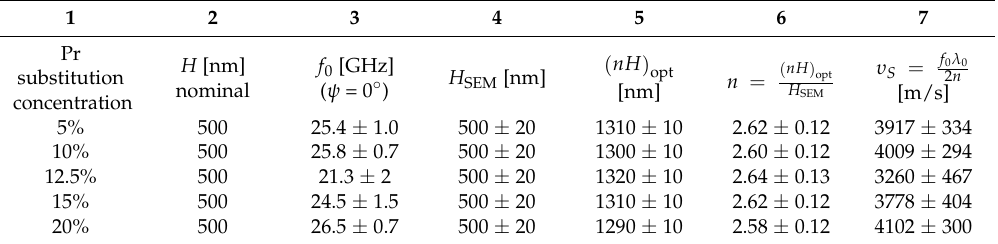
Table 3. Evaluation of the parameters of (Bi 1 − x Pr x )(Fe 0.95 Mn 0.05 )O 3 films deposited on LaAlO 3 (LAO) by combining TDBS, optical reflectivity, and scanning electron microscope (SEM)